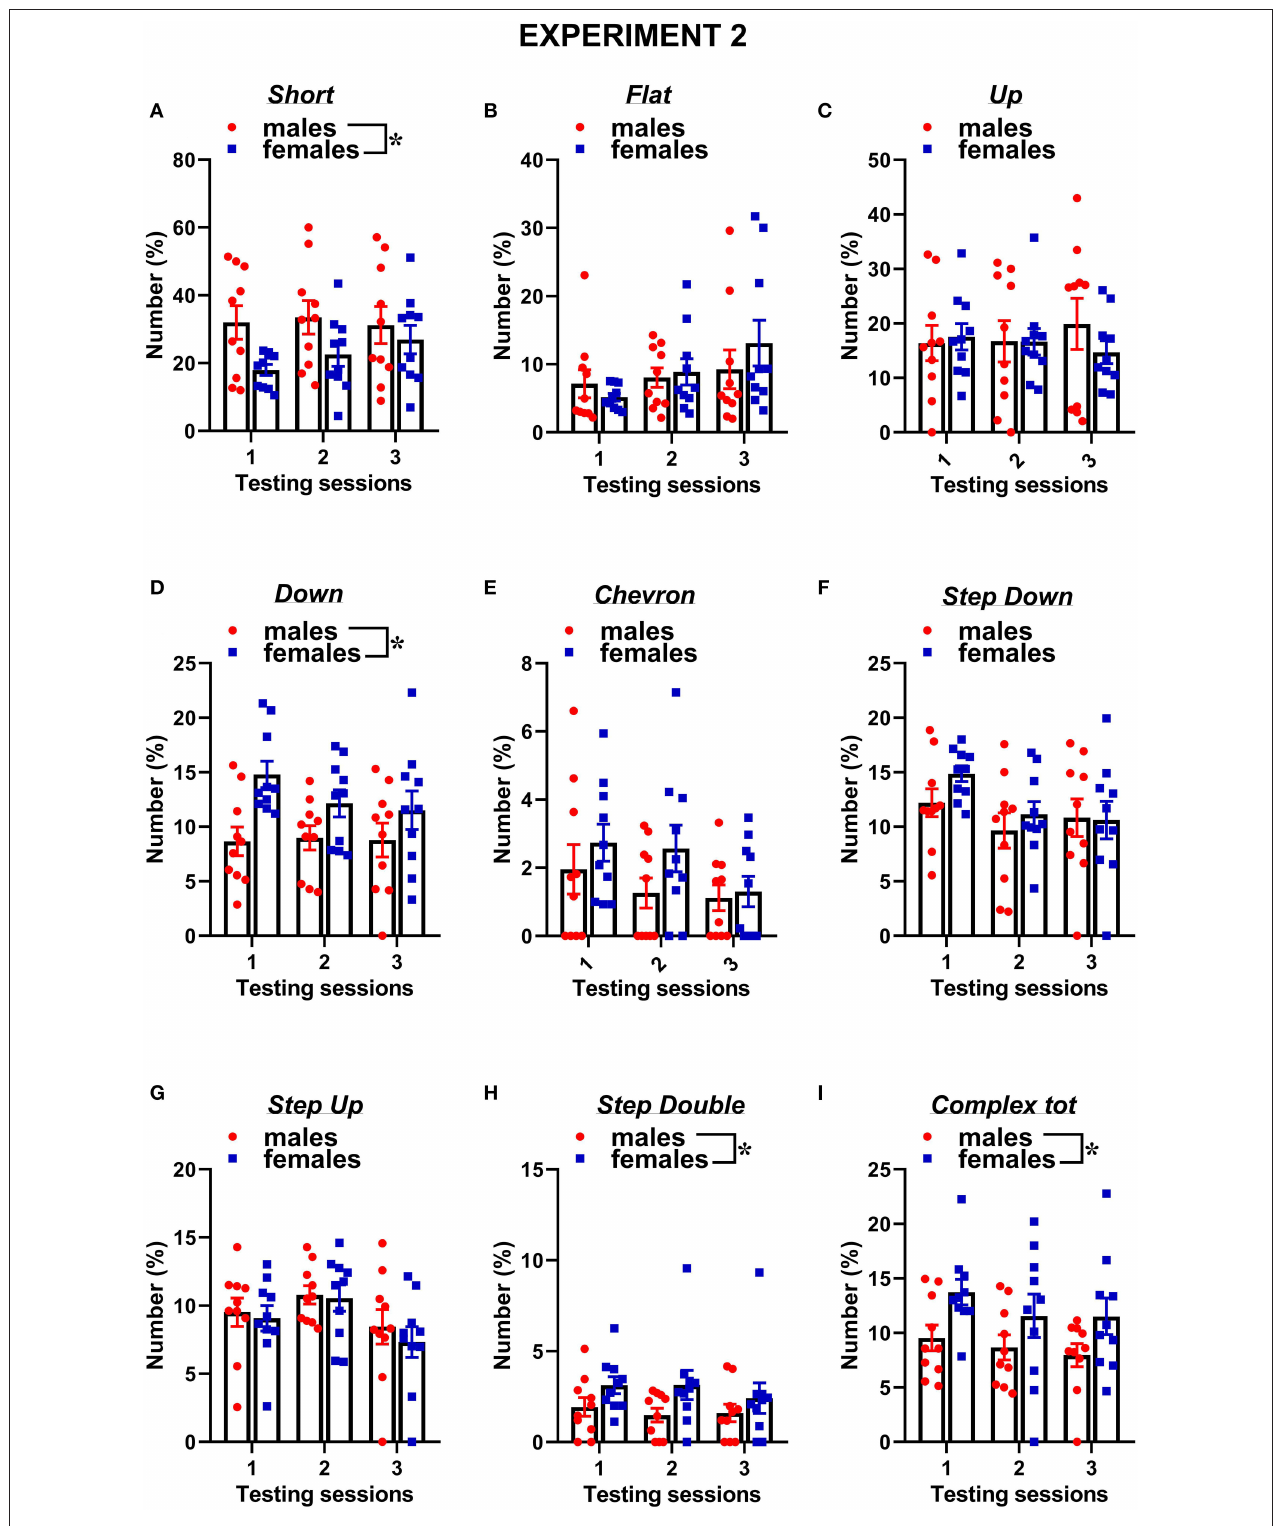
FIGURE 7 | Sex differences in ultrasonic call types in experiment 2 (different pre-testing isolation). (A-I) The different call types were automatically classified (refer to Figure 1 for a detailed description). Complex tot = complex 3 + complex 4 + complex 5. Data are expressed as percentages over the total number of USVs for each sex and session. Data are mean ± SEM. N = 10 for each sex. * p < 0.05.* Refers to a nonsignificant tendency (0.05 < p ≤ 0.09). Sex differences are reported as * in each graph legend when a significant main effect of sex was detected in the absence of any interaction with testing session.